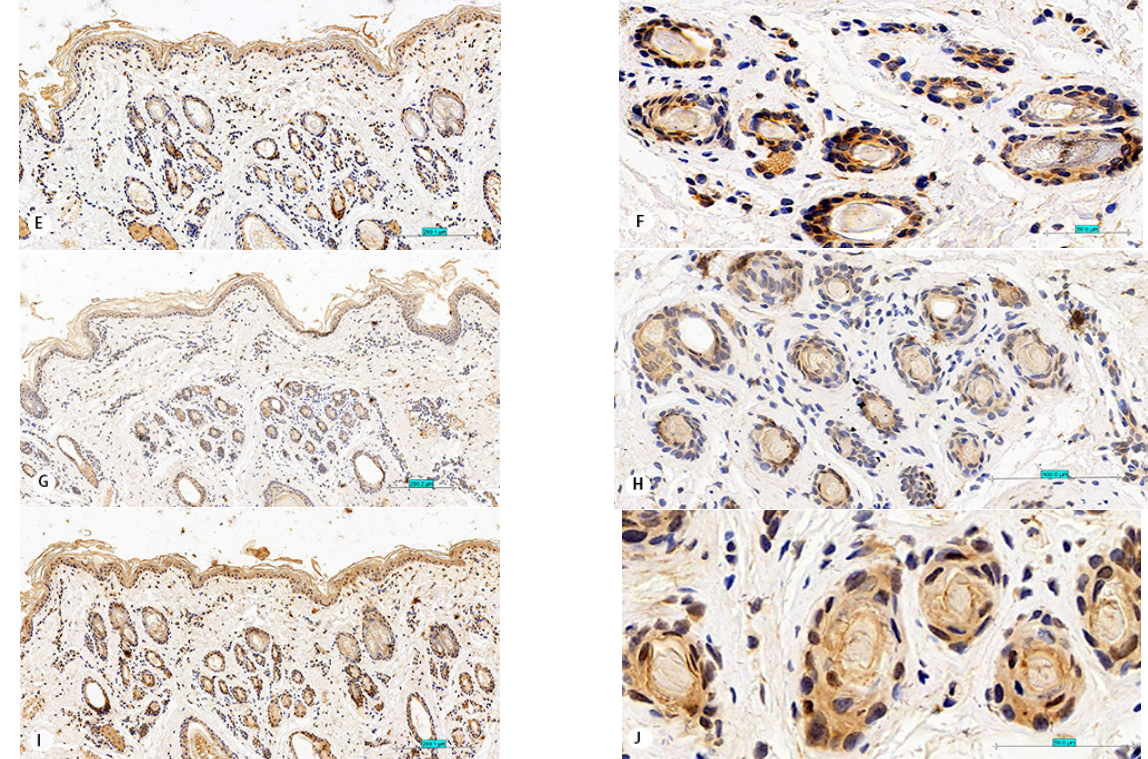
Figure 3. Immunostaining of HIF-1a, HIF-2a, HIF-3a, HSP27, and HOCX13 in secondary hair follicles of Tibetan cashmere goats. ( A , B ) HIF-1a immunostaining is present in the inner root sheath and hair shaft. ( C , D ) HIF-2a immunostaining in outer root sheath and inner root sheath. ( E , F ) HIF-3a immunostaining in outer root sheath. ( G , H ) HSP27 immunostaining in outer root sheath, inner root sheath, and hair shaft. ( I , J ) HOCX13 immunostaining in outer root sheath and hair shaft. ( A , C , E , G , I ) 100×; ( D , F , H ) 200×; ( B , J ) 400×.